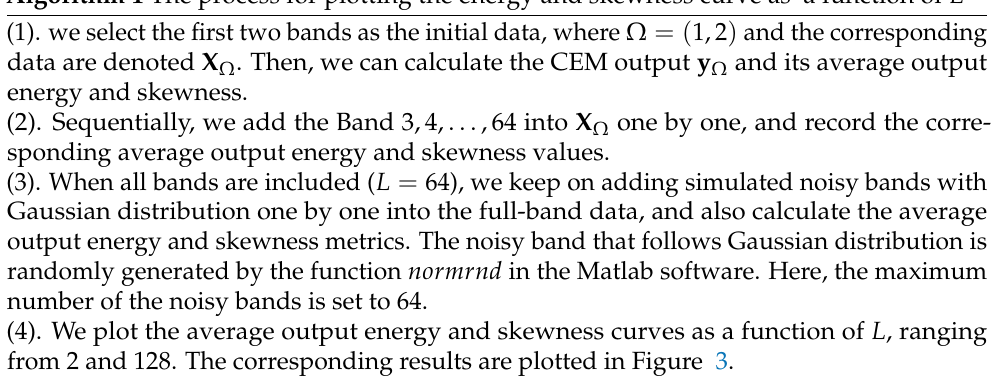
Algorithm 1 The process for plotting the energy and skewness curve as a function of